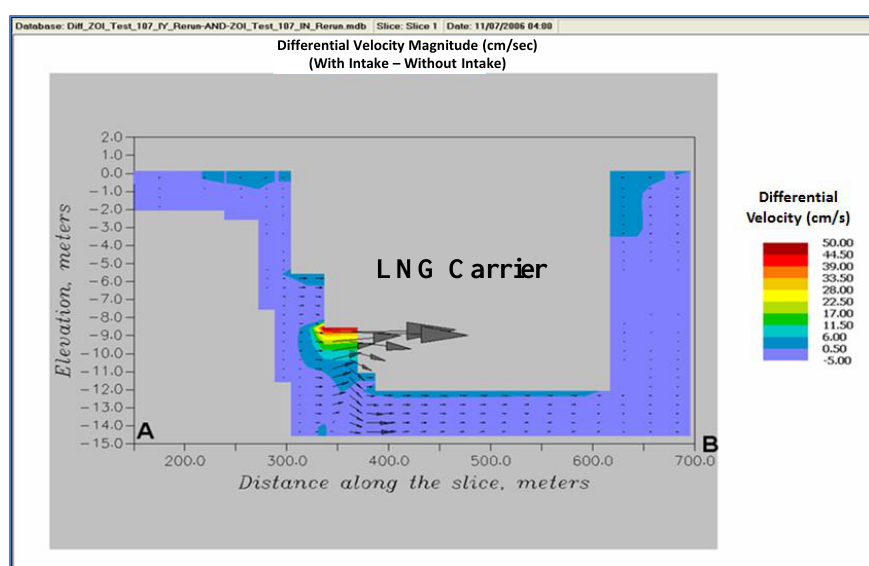
Figure 7. Differential velocities.